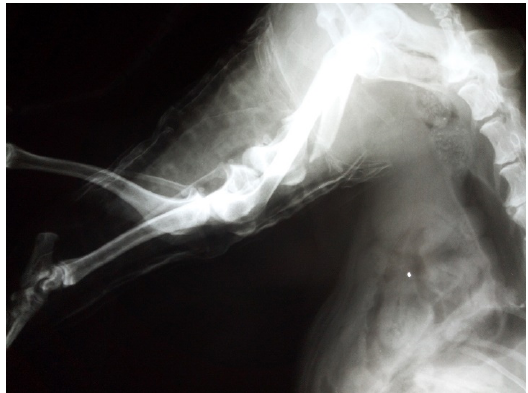
Fig. 1. Radiography in old dog showed multiple fracture Fig. 3. New design interlocking nail (BlueSAO R ) instru- of femur ment, maxillofacial titanium plate, screws, and wire The 2.5 mm double trocar intramedullary pin was insert- ed from the fracture line to the proximal segment passed proximal locking screw to trochanteric fossa then retrograde to distal segment passed distal locking screw until the tip of pin engaged distal femur. The fixation screws were placed to the locking screws for locking 2.5 intramedullary pin (Fig. 4).